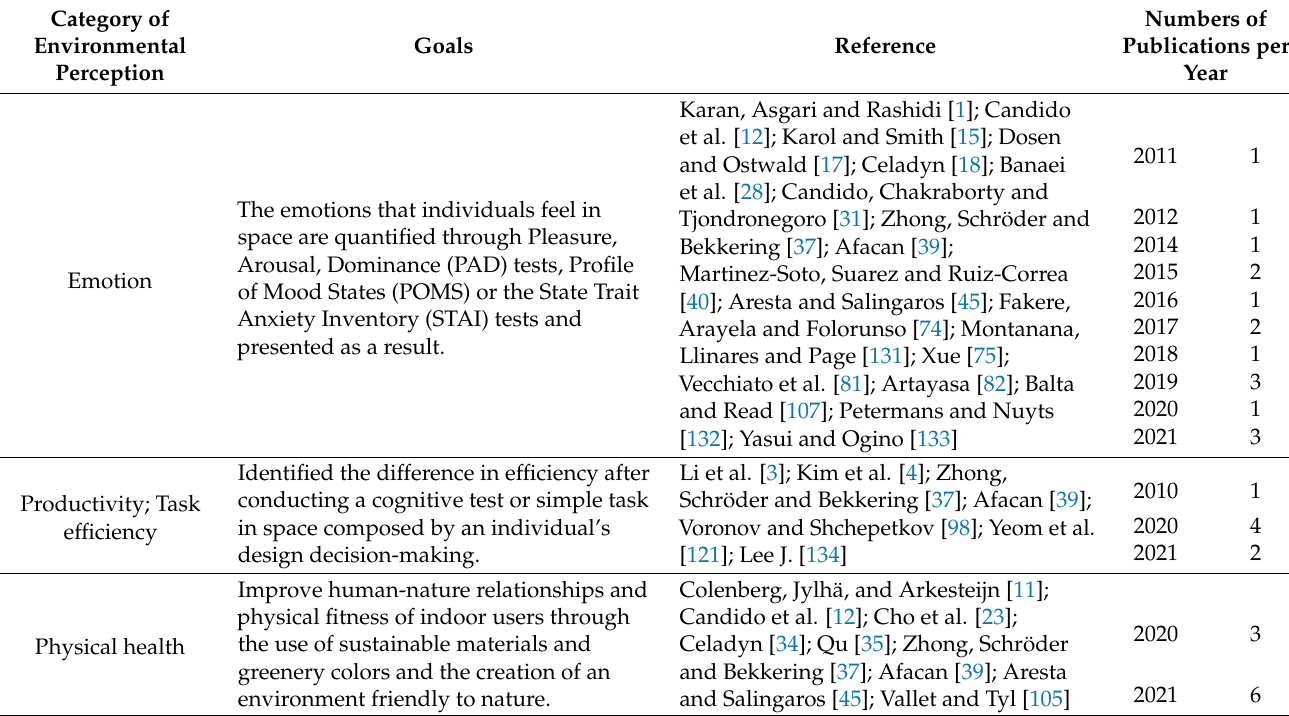
Table 6. Results of literature review on spatial